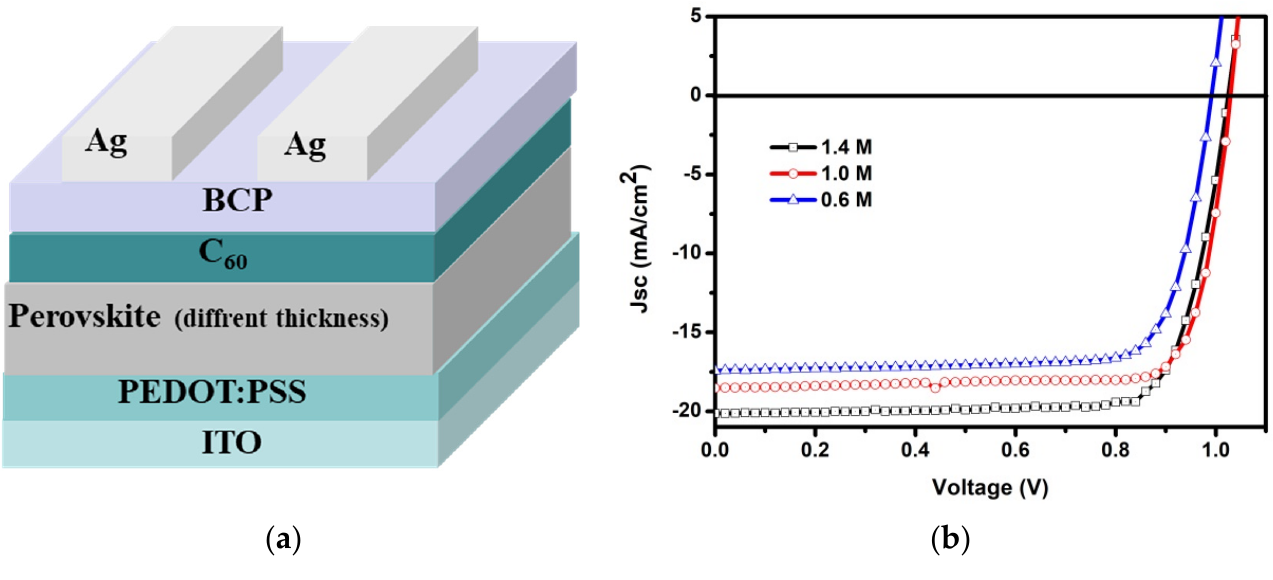
Figure 1. ( a ) Schematic architecture of the inverted PSCs. ( b ) J - V characterization of the inverted PSCs with perovskite layer prepared by different concentrations (1.4 M, 1.0 M and 0.6 M) of precursors. Table 1. The photovoltaic parameters of inverted PSCs with the structure of